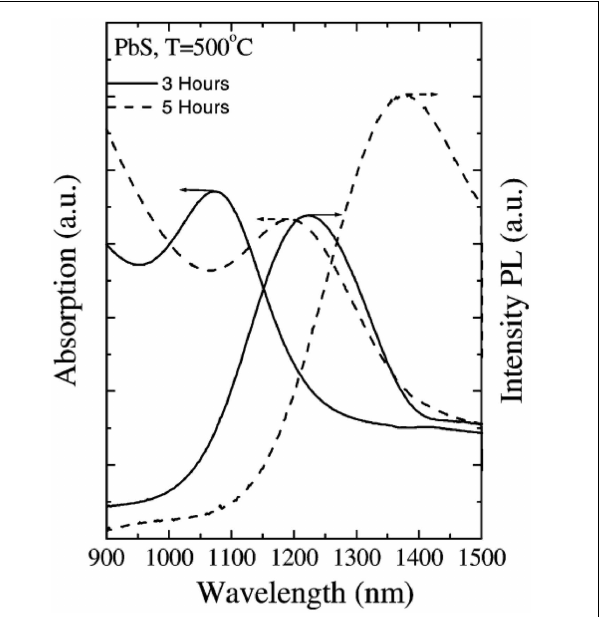
FIGURE 3 |Absorption and PL spectra of PbS QD-doped glass heat-treated for 3 and 5h (Silva et al., 2003)